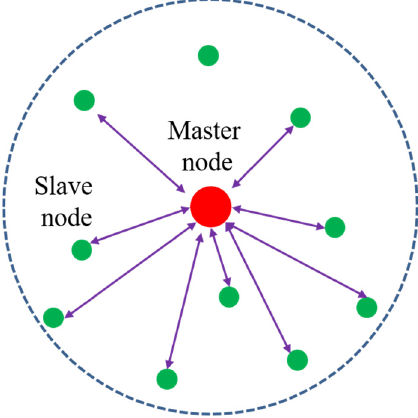
Figure 1. The architecture of the UWASN to apply the API protocol.